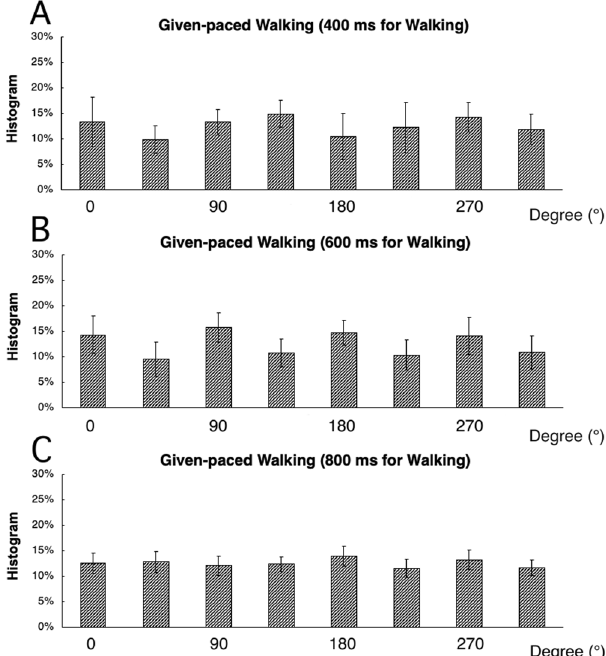
Figure 4. Normalized distribution of the relative phase of the given-paced walking task for walking intervals of 400 ms ( A ), 600 ms ( B ) and 800 ms ( C ). Bars are